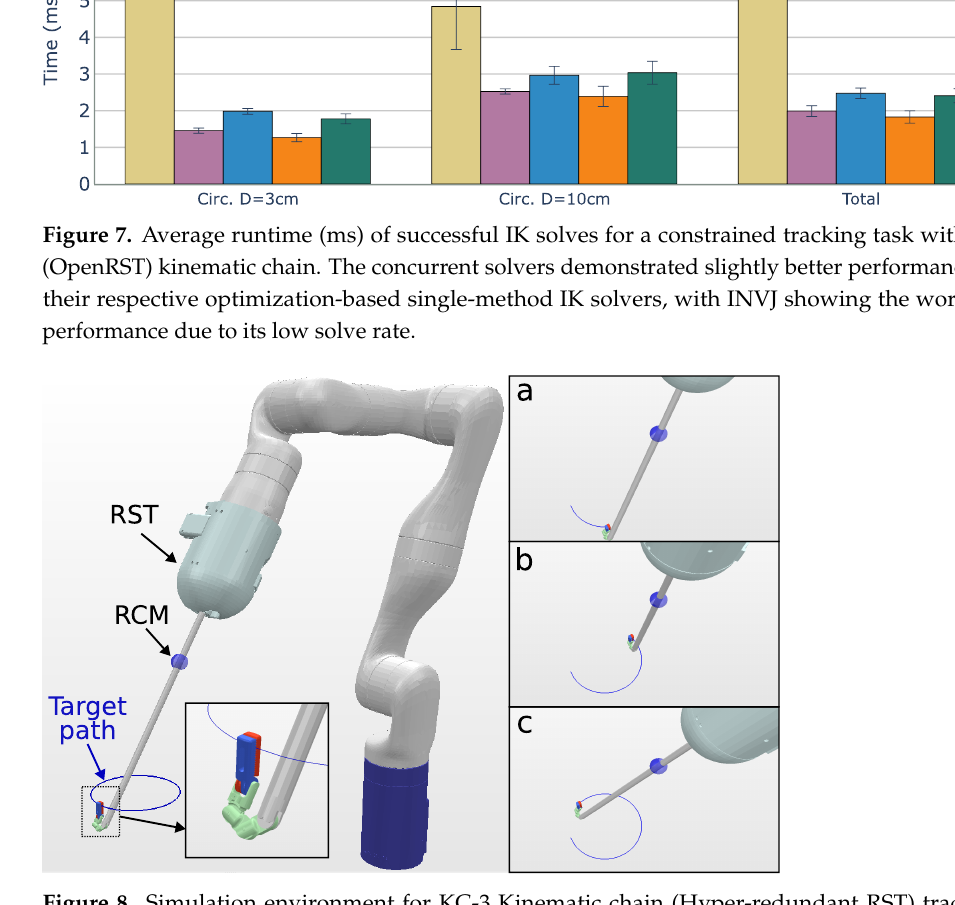
Figure 8. Simulation environment for KC-3 Kinematic chain (Hyper-redundant RST) tracking a 10 cm circular path. In the close-up view, the tool tip target orientation. The trajectory followed by the surgical tool tip is visualized in blue, and snapshots ( a – c ), shown on the right, depict the robot executing the tracking task at different trajectory steps.